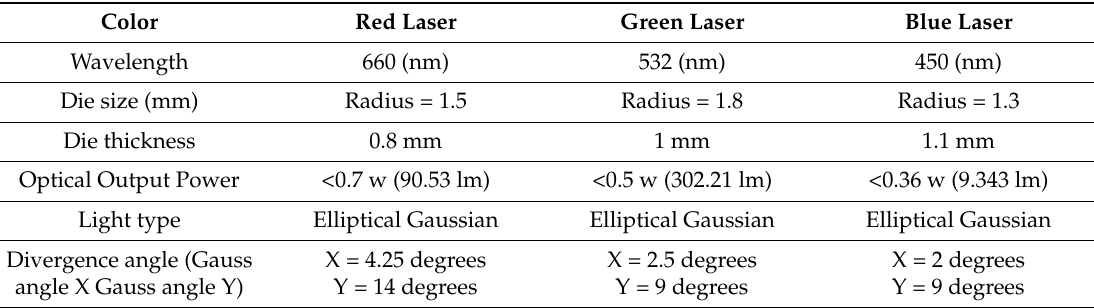
Table 1. Selection specification for a single laser source.